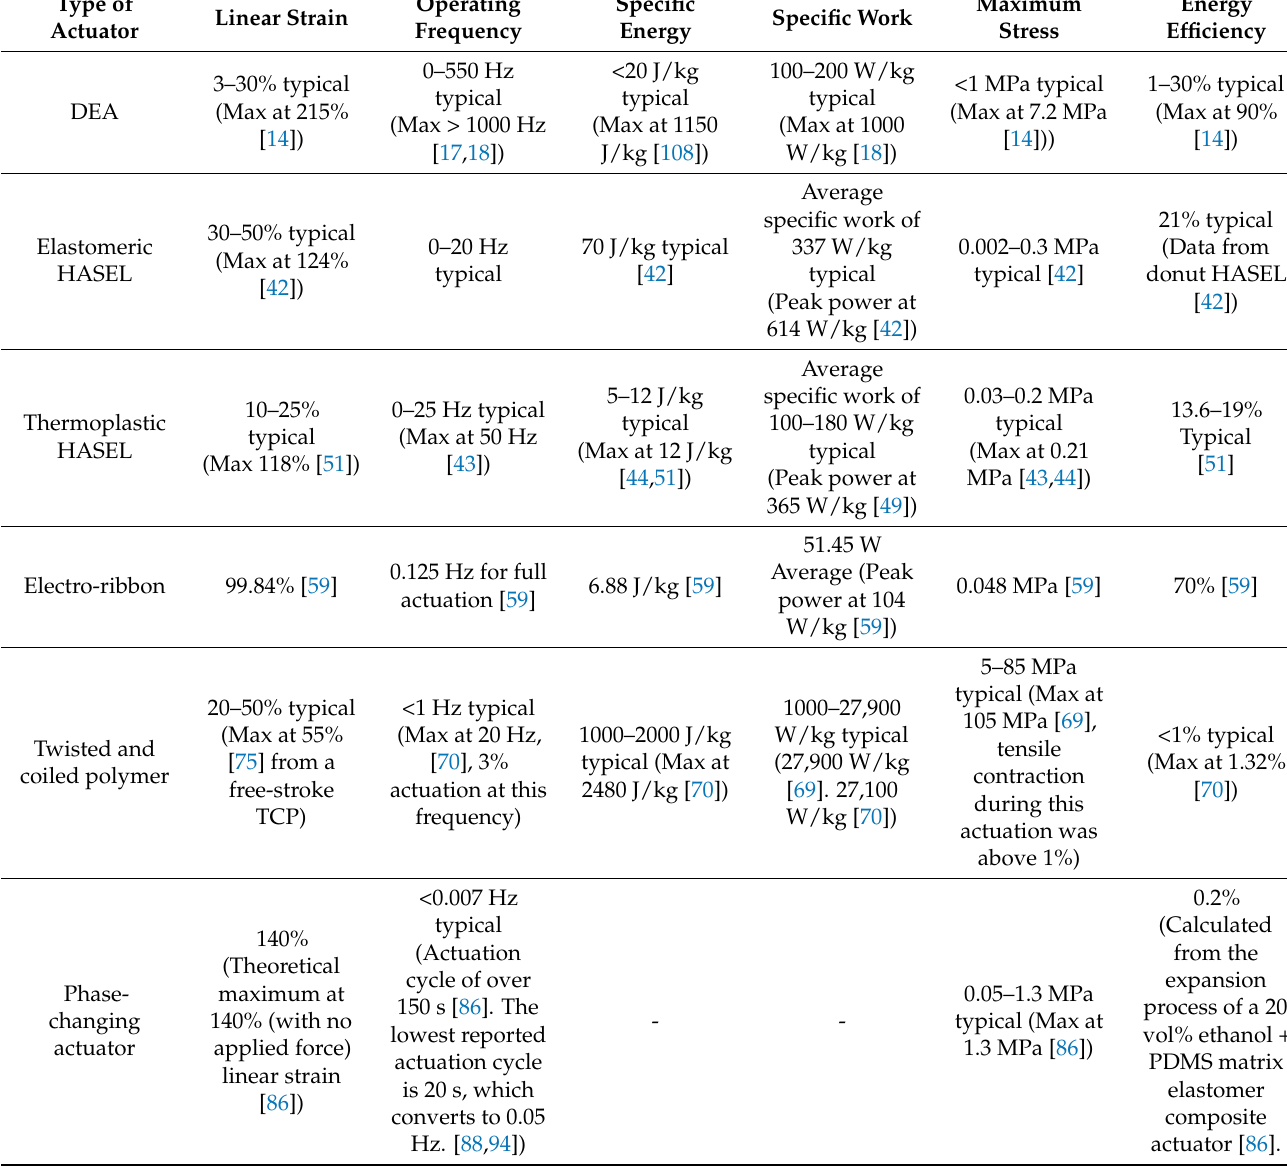
Table 2. Quantitative comparison of actuator key parameters. The values marked typical are obtained based on the authors’ overall understanding of the